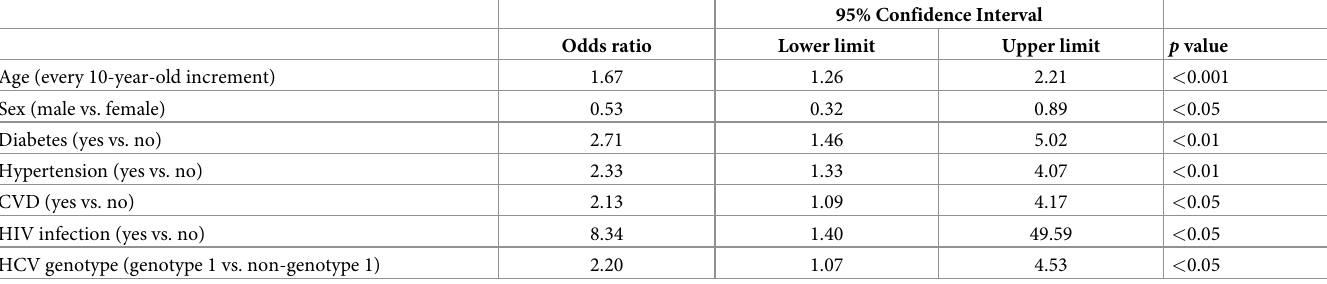
Table 3. Risk factors of kidney disease among individuals with detectable hepatitis C virus ribonucleic acid (RNA) by multivariable logistic